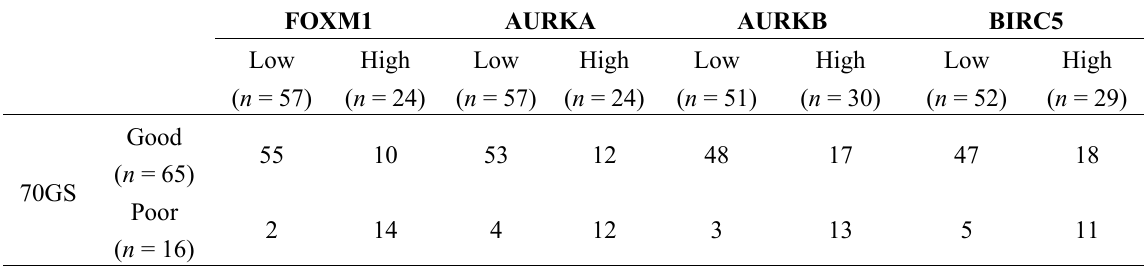
Table 4. Agreement between each genetic marker and